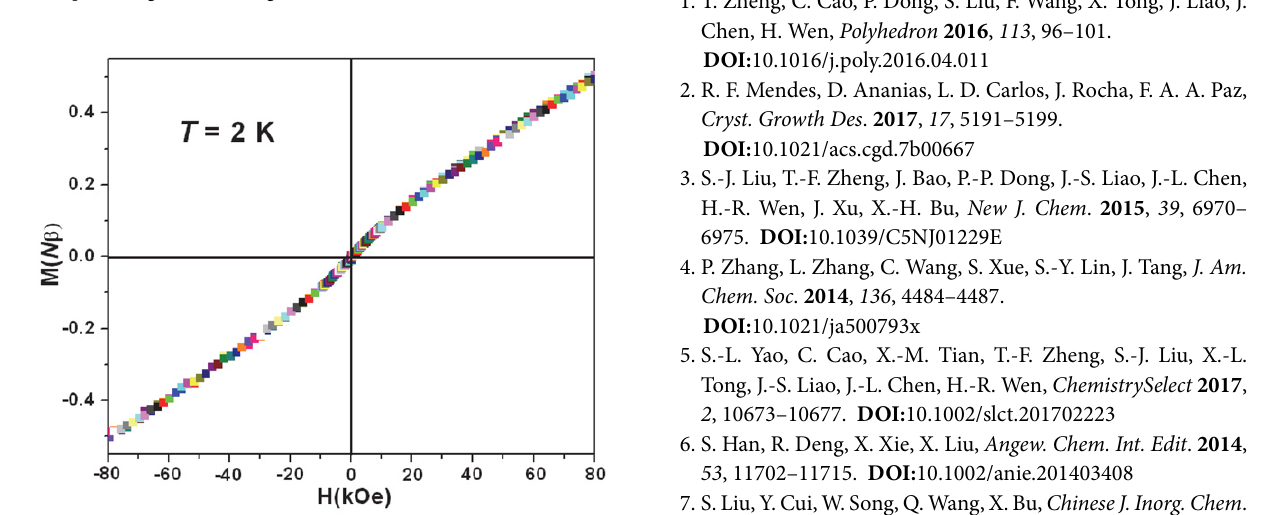
Figure 6. Thermal dependence of χ M and μ eff for 1 with the red line representing the best fitting curve